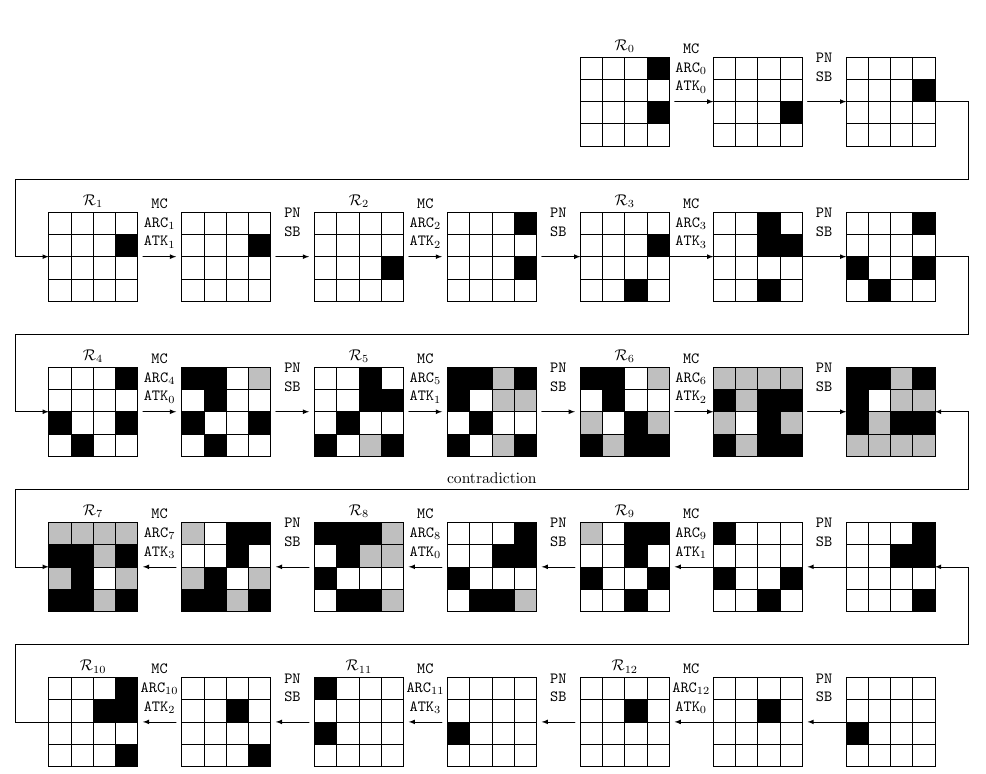
Figure 5: A 13-round impossible differential characteristic for CRAFT . Note that active nibbles of the plaintext difference have the same